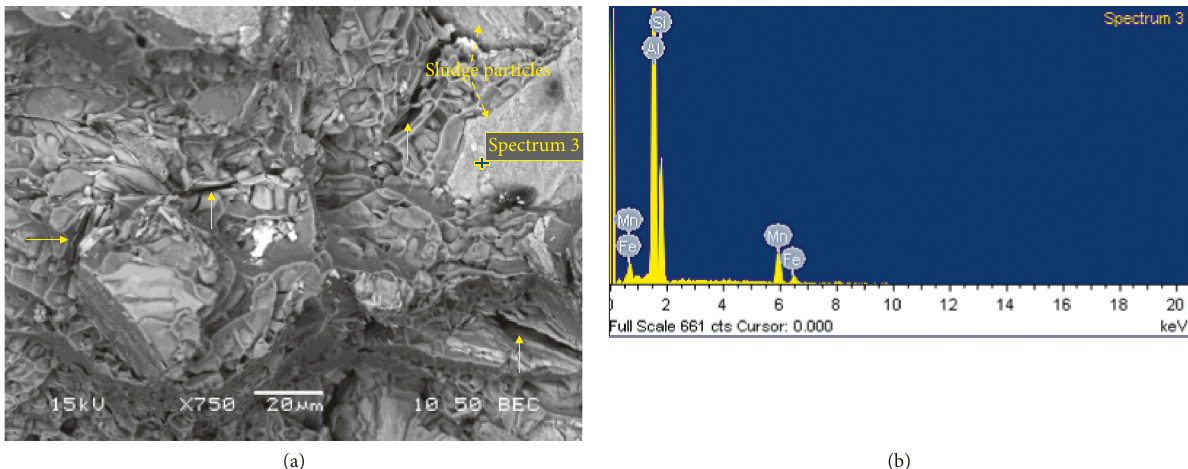
Figure 7: SEM images of T6-treated M3S alloy after testing at 250 ° C: (a) BSE image showing various cracked intermetallic phases and crack- free sludge particles and (b) EDS spectrum corresponding to the point of interest in